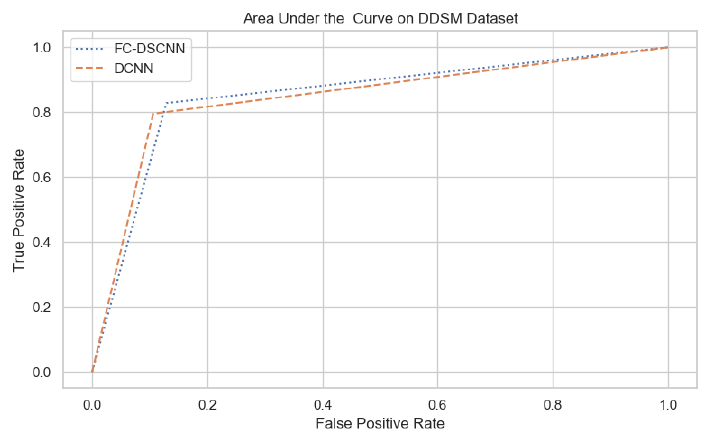
Figure 20. The AUC curve of the proposed method on the DDSM dataset is 0.86, which is higher than the DCNN, which is